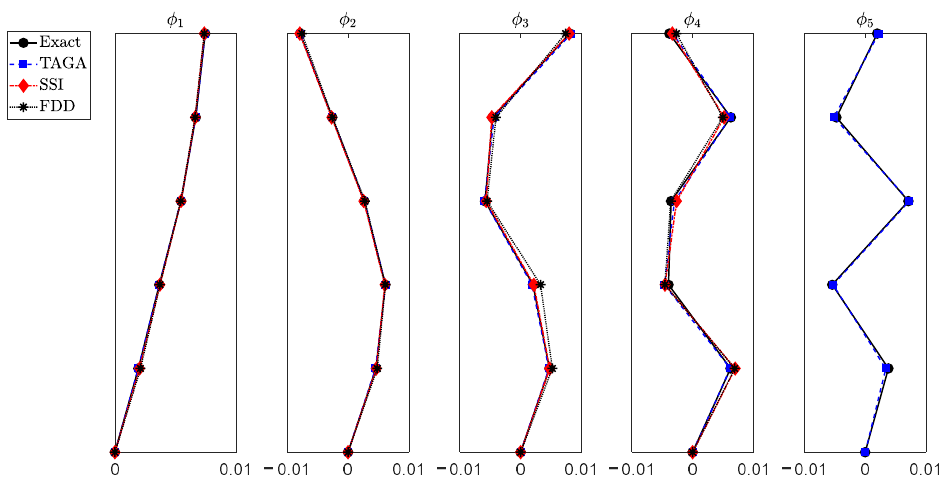
Figure 5. Comparison between the identified modal shapes and the exact ones for the 5DoF system. Table 9. Discrepancy between the estimated FRF matrix in nodal space and the exact one for the 5DoF system.